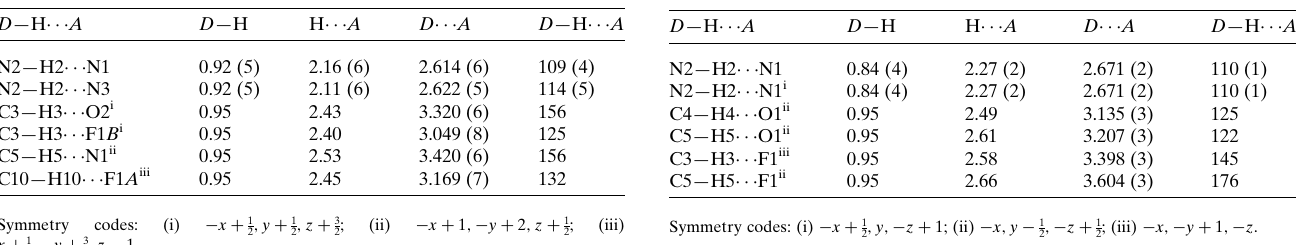
between the imide N2—H2 hydrogen atom and both pyridine nitrogen atoms are observed [N2—H2 (cid:4) (cid:4) (cid:4) N1 = 2.16 (6) A˚ ; N2—H2 (cid:4) (cid:4) (cid:4) N3 = 2.11 (6) A˚ ], while non-classical inter- molecular hydrogen bonds occur between the first pyridine rings and carbonyl O2 atoms of symmetry-equivalent mol-